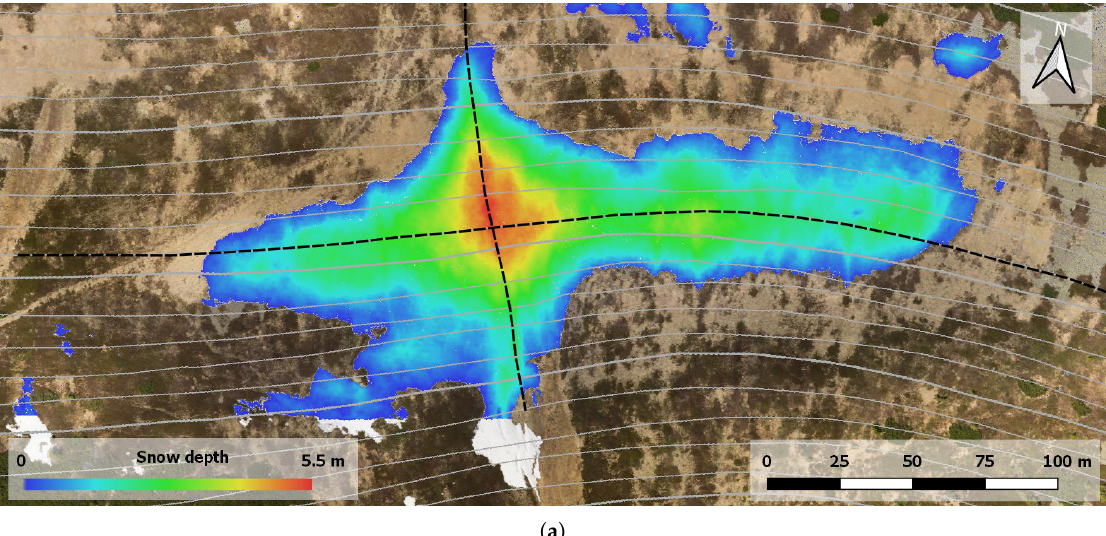
Figure 14. The height difference between the snow-covered, photogrammetry-based DSM and the snow-free, ALS-based DTM ( a ). This result involves differences caused by not only the snow itself but also other aspects, including, for example, vegetation (upper right corner). After the SCA mask has been applied, the difference map contains the SD only ( b